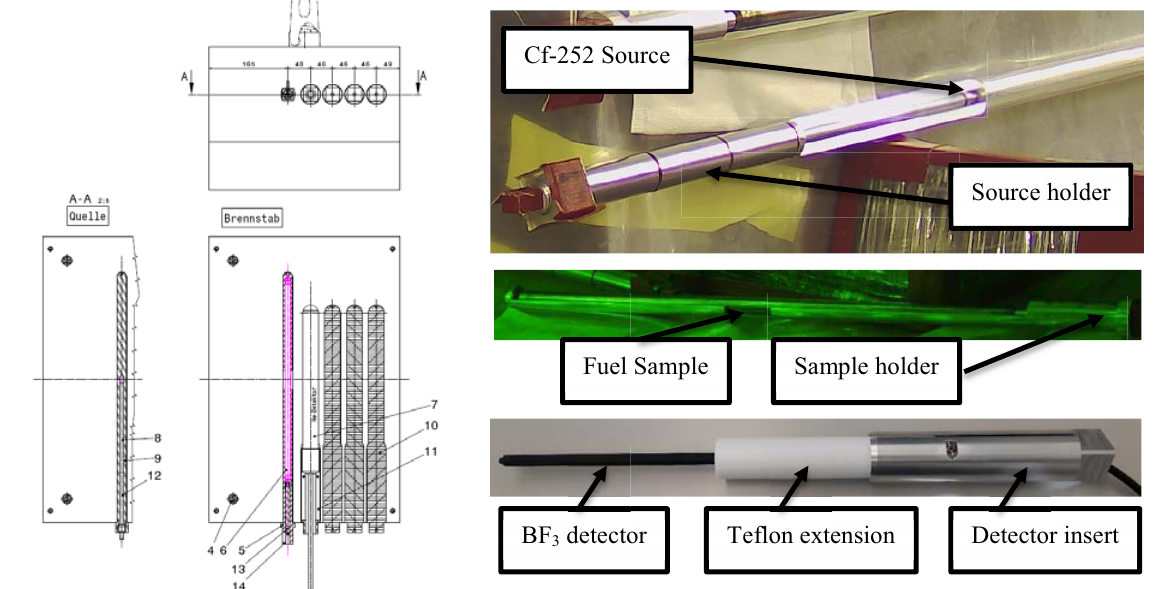
Figure 1. Measurement station top and side view (left); pictures of source holder, sample holder